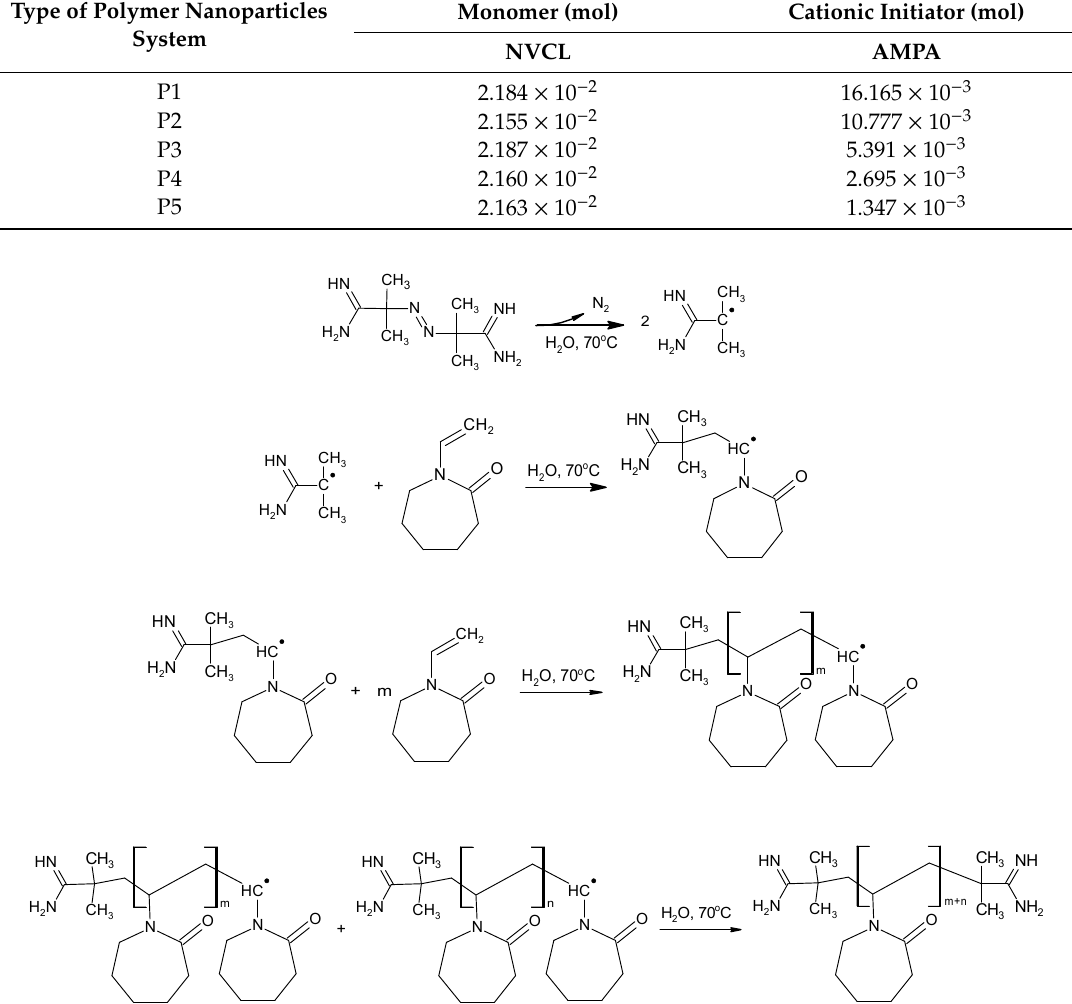
Table 1. Compositions of P1, P2, P3, P4, and P5 nanoparticles.